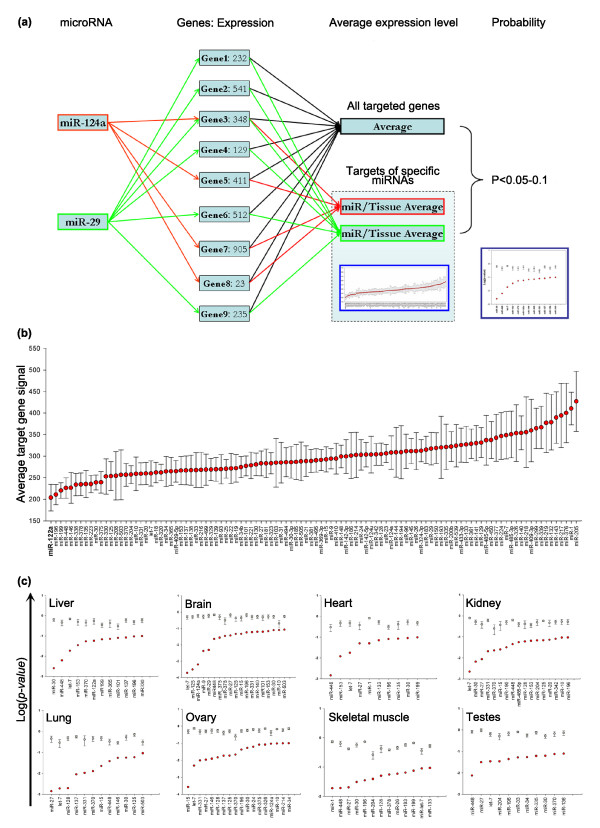
Average mRNA expression of the predicted target genes for each miRNA. (a) Schematic diagram illustrating how the average expression levels of individual miRNA predicted target gene sets are calculated and then compared with that of all predicted target genes. In this example miR-124a and miR-29 are shown to map to different, but overlapping, subsets of target genes. The average expression values of all predicted target genes and the miR-124a and miR-29 predicted targets are calculated. The probability that the expression levels of the genes predicted to be targeted by miR-124a and miR-29 in this tissue are drawn at random from the expression levels of all predicted target genes is calculated. (b) Ranked mean expression values (y-axis) of all predicted target genes for each miRNA (x-axis) with target genes expressed in liver are depicted as red circles (± standard error). These include the predicted mRNA targets of the known liver-specific miR-122 (extreme left). Several miRNAs have higher than expected target gene expression, for example, miR-1 and miR-205 (extreme right). (c) Red circles indicate the probability (log10, y-axis) that the set of target gene expression levels for each miRNA (x-axis) is drawn at random from the whole population of expressed target genes for all miRNAs (t-test, p < 0.1). For each miRNA the mean probability (± standard error) derived from five random sets of predicted target genes is plotted in grey.